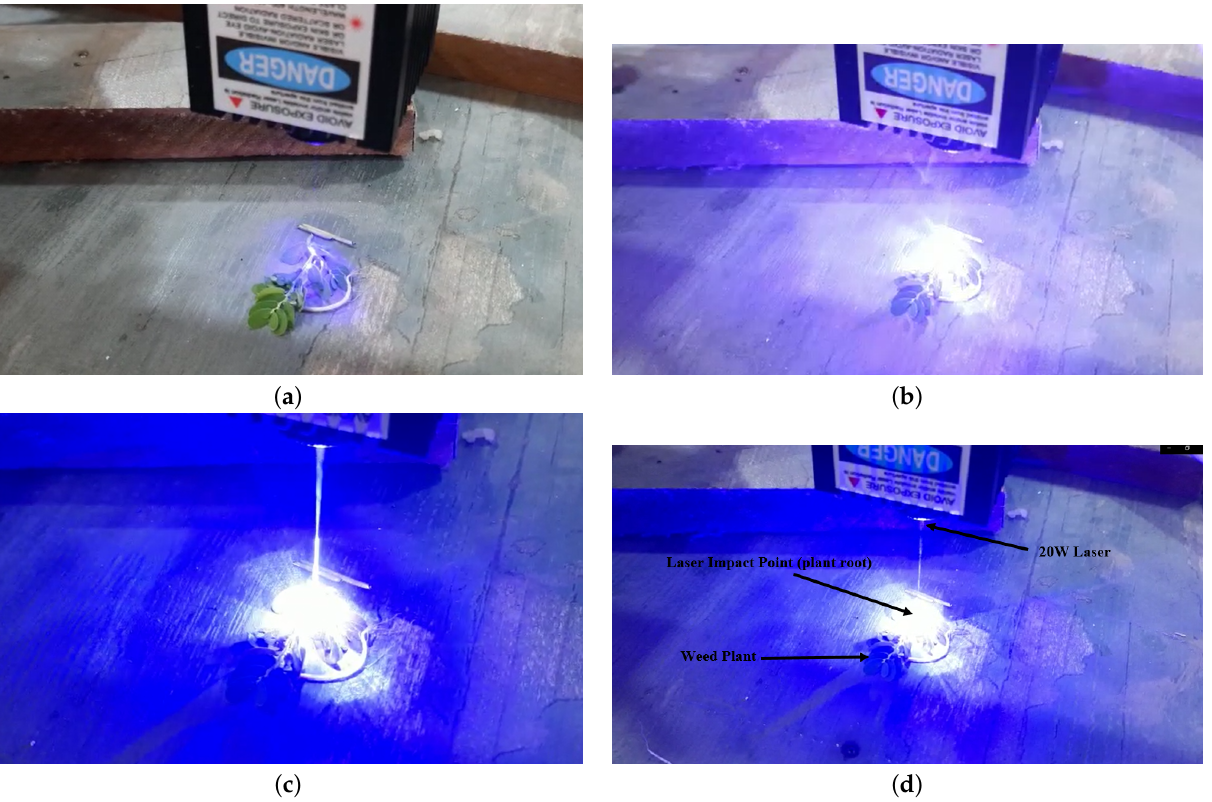
Figure 10. Testing of laser-based weed elimination system in lab environment. ( a ) Laser initiated ( b ) Target acquired ( c ) Laser at max intensity killing weed ( d ) Laser burnt the stem hence, job is